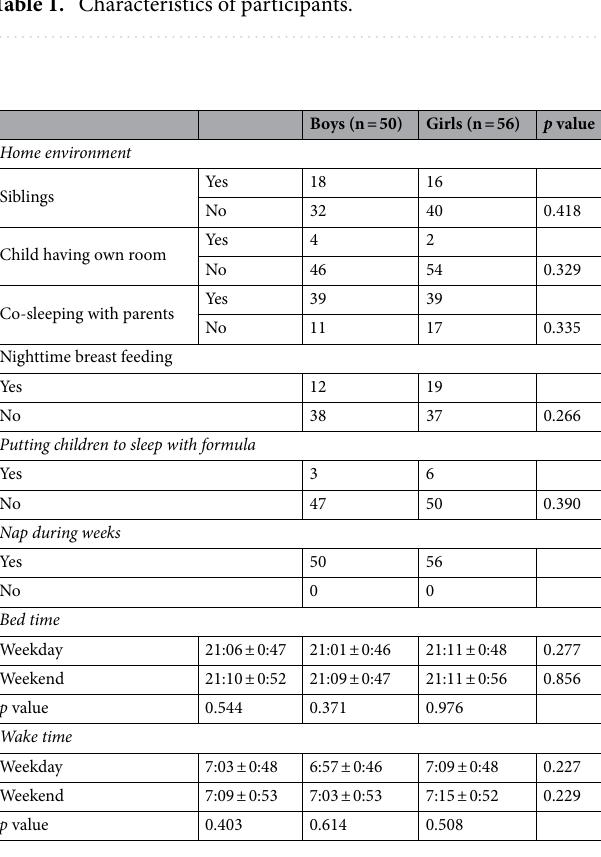
Table 2. Sleep arrangements and sleep variables by gender (number or mean ±